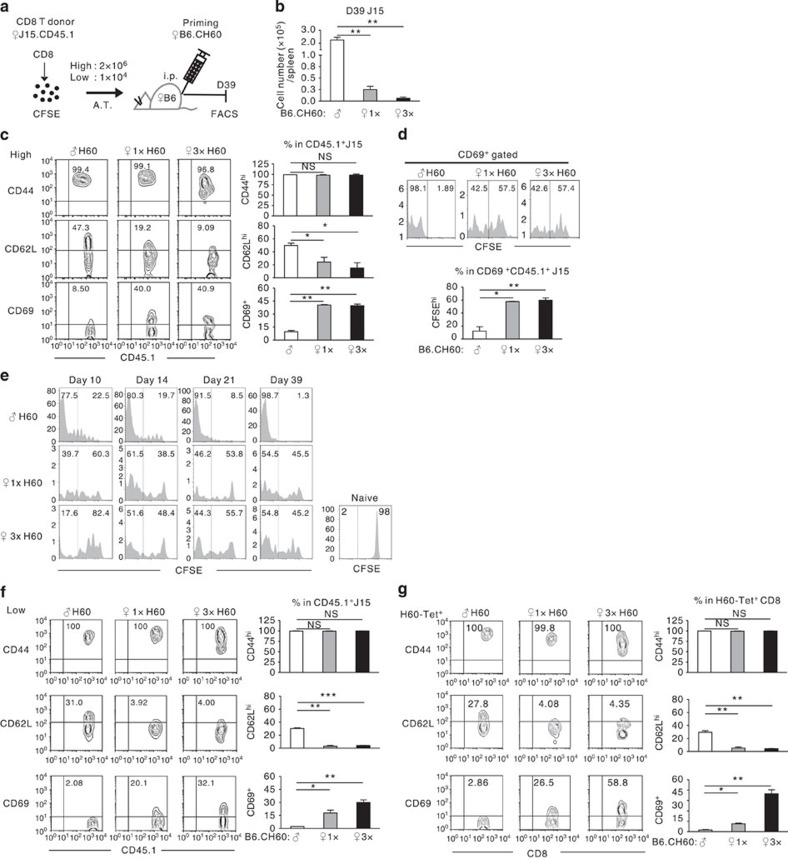
Memory phenotypes of H60-specific CD8+ T cells under different conditions.(a) Schematic presentation of the experimental procedure for analysis of the helped and helper-deficient H60-specific CD8+ T cells. CFSE-labelled CD45.1+ J15 CD8+ T cells were adoptively transferred (A.T.) into female B6 mice at a high (2 × 106) or low (1 × 104) number. Then, the adoptive hosts were primed under helped or helper-deficient conditions (1 × and 3 × helper-deficient conditions). Splenic J15 CD8+ T cells harvested on day 39 post priming were analysed. (b) The numbers and (c) representative flow cytometric data with plots of the proportions of different populations in J15 CD8+ T cells harvested from spleens of adoptive hosts with higher number transfer (high) are shown. (d) CFSE profiles after gating for CD69+cells, and the proportion of CFSEhi populations in the CD69+ CD45.1+ J15 CD8+ T cells are shown. (e) CFSE-dilution peaks of J15 CD8+ T cells harvested at the indicated time points. The CFSE profile of naive J15 CD8+ T cells on day 21 after PBS injection into adoptive hosts is shown as the naive control. (f,g) Phenotypic analyses of (f) splenic J15 CD8+ T cells after low-number transfer (1 × 104; low) and (g) polyclonal H60-tetramer-binding CD8+ T cells magnetic-activated cell sorting-purified from spleens of primed B6 hosts (without J15 transfer; H60-Tet+) were performed on day 39 post priming. Mice in each experimental group (b–g) were analysed individually (n=2 per group). Flow cytometric results were analysed after gating for CD45.1+CD8+ cells (b–f) or CD8+ cells (g). All data (b–g) are representative of more than three independent experiments. The values from all experiments were incorporated into plots (b–g). Data are presented as means±s.e.m. Not Significant (NS) P>0.05. *P<0.05, **P<0.01, ***P<0.001 determined by Student's t-test.